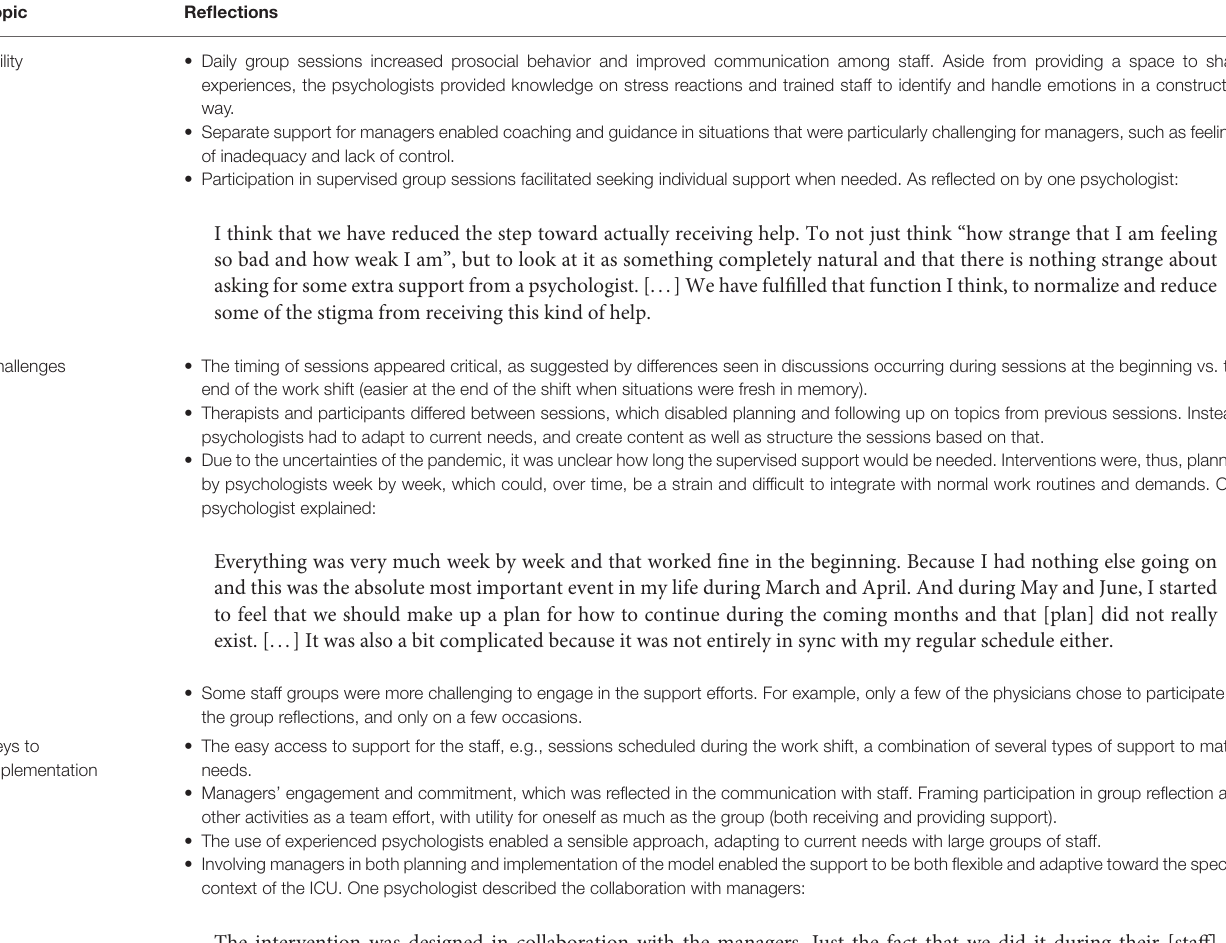
TABLE 2 | Summary of psychologists’ reflections on content and implementation of the support